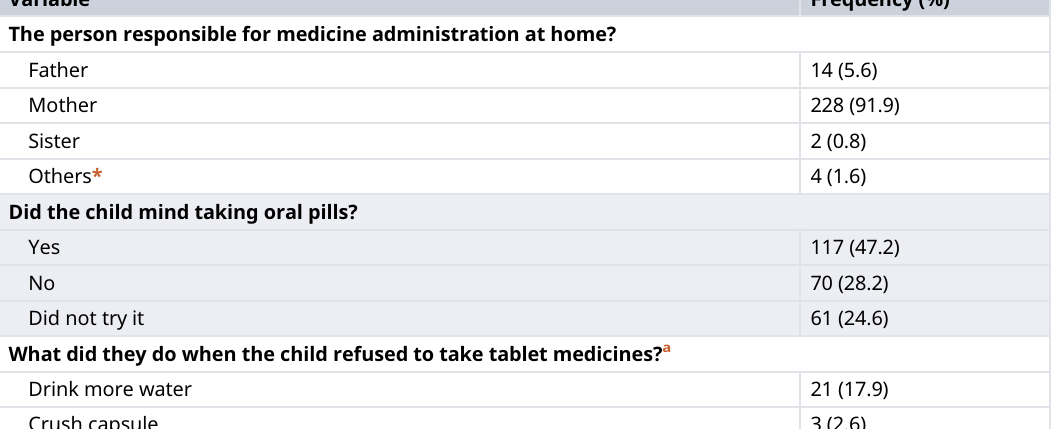
Table 2. Oral medicine administration at home and acceptance behaviors of children (N =